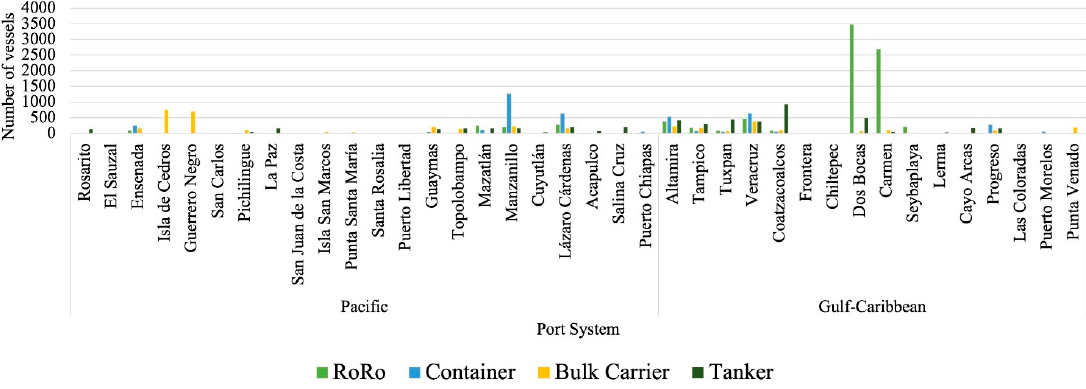
Figure 6. Arrivals by type of vessel at each Mexican port during 2020.